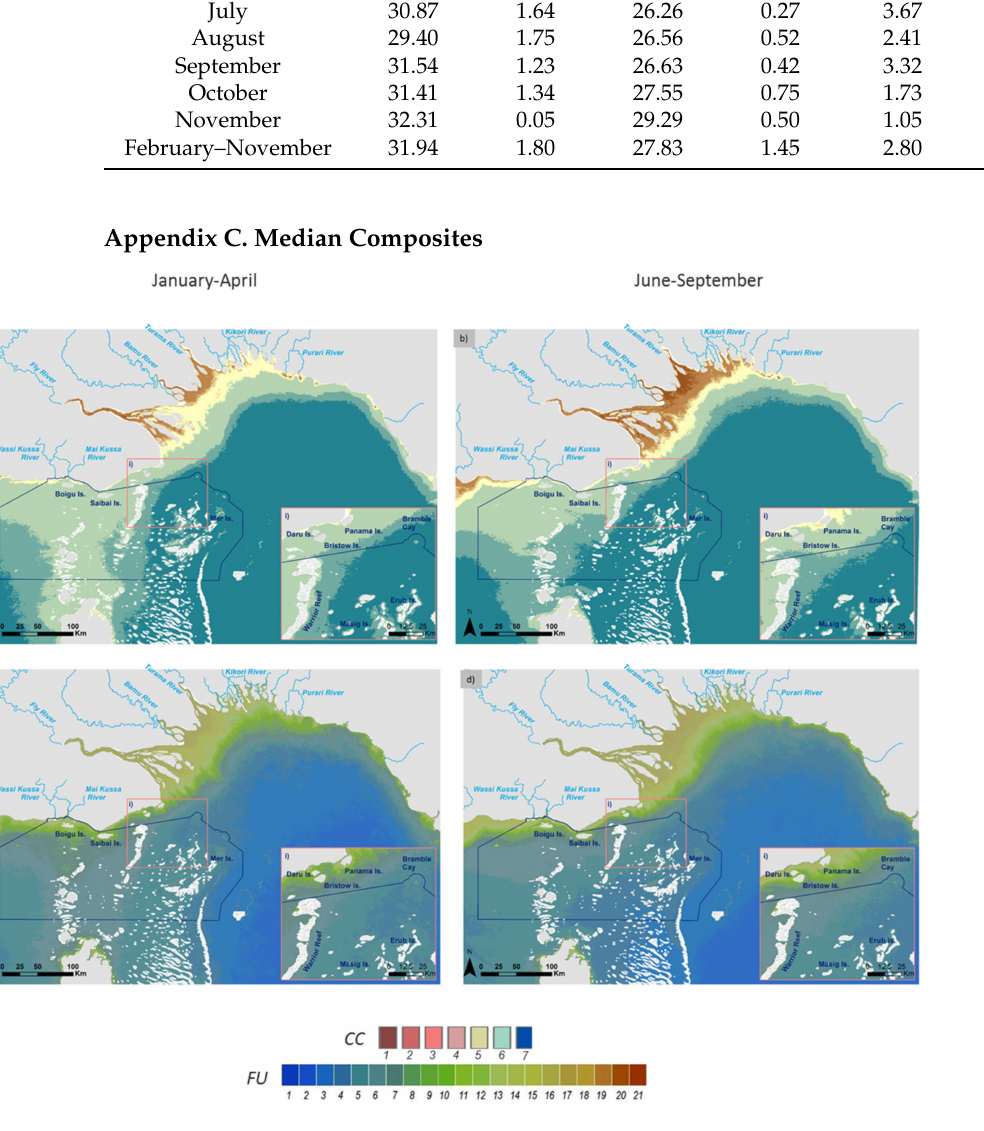
Figure A5. Median composite maps for the January–April (monsoon period) and June–September (SE trade wind season): ( top ) MA-WS ( a , b ) and ( bottom ) S3-FU composites ( c , d